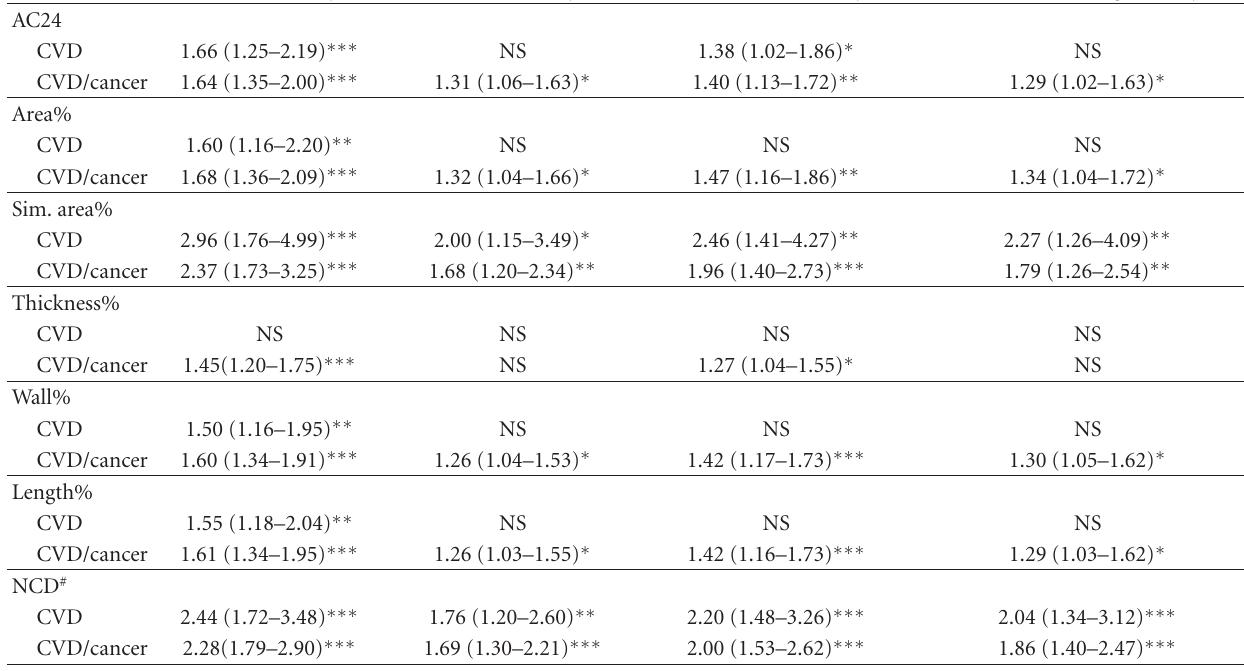
Table 4: The relative risk per standard deviation increase in marker values stratified into death cause and adjusted for physical/metabolic markers, EU SCORE, and Framingham score, respectively. The symbols ∗ , ∗∗ , and ∗∗∗ denote the significance corresponding to P < 0 . 05, P < 0 . 01, and P < 0 . 001, respectively. NCD # stands for number of